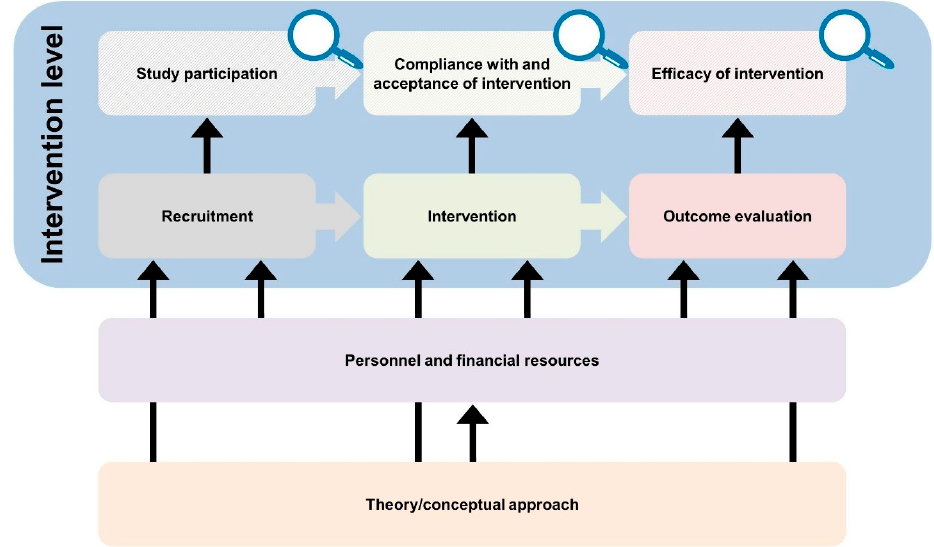
Figure 1. General equity-focused logic model.